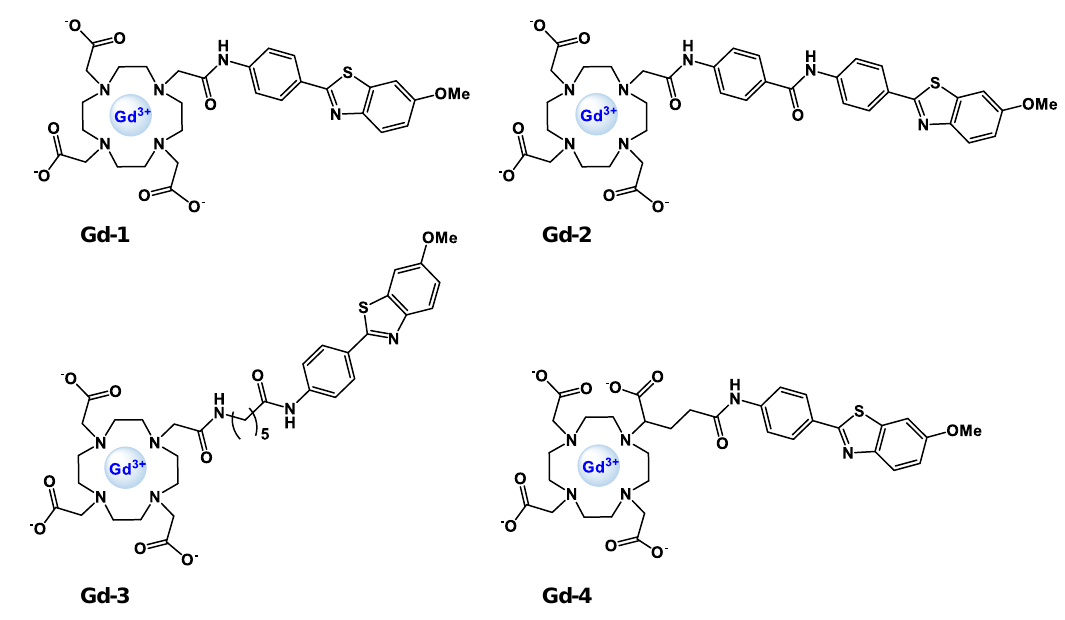
Scheme 7. Structures of PiB-based DOTA